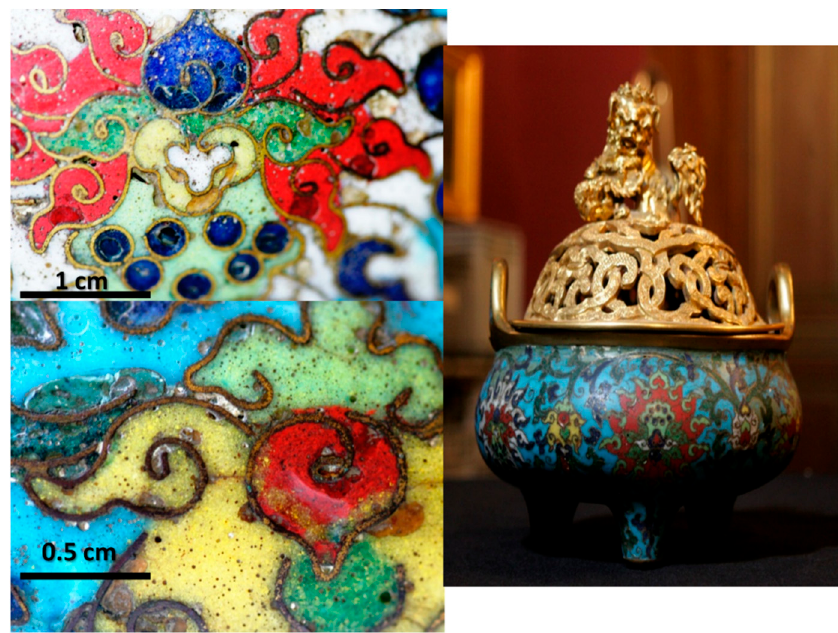
Figure 2. The incense burner (F1448C) and details of the cloisonné enameled décor (Kangxi reign). Note the many bubbles in the décor revealed by surface polishing.